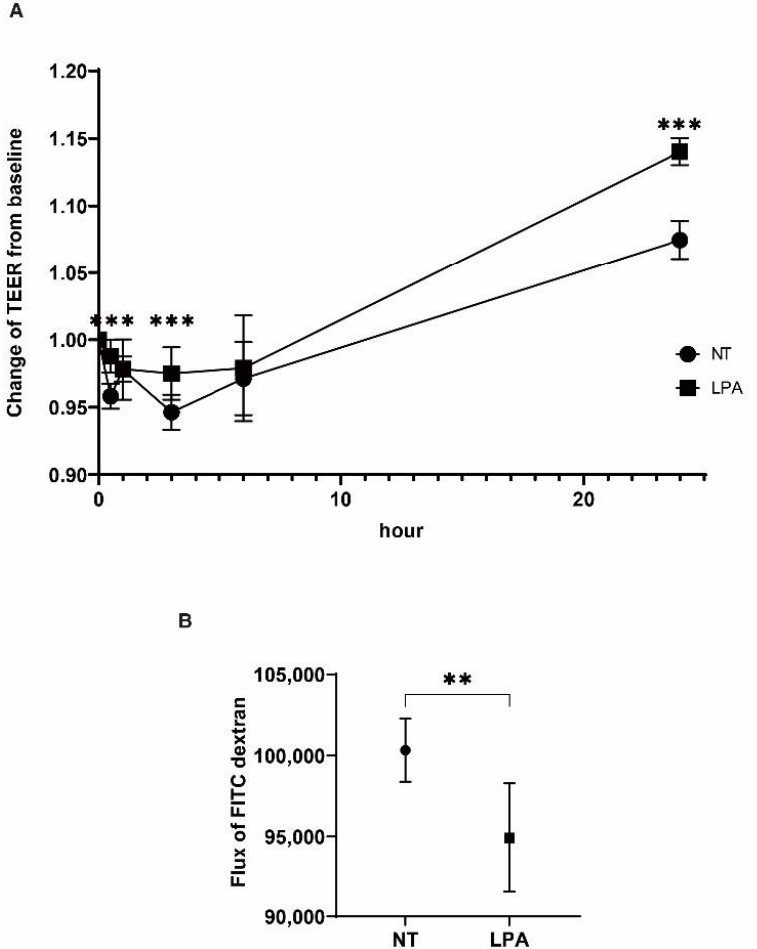
Figure 2. Effects of LPA on transendothelial electrical resistance (TEER) and FITC-dextran permea- bility of 2D cultures of HTM cell monolayers. Among the conditions in which the 2D cultured HTM monolayers were either untreated (NT) or treated with 200nM LPA, TEER (Ωcm 2 ) values were meas- ured at different time points (0, 0.5, 1, 3, 6 and 24 h) and plotted (panel A ). Alternatively, 2D cultured HTM monolayers were either untreated (NT) or treated with 200 nM LPA for 24 h, and was FITC- dextran permeability was measured and the data plotted in panel B . All experiments were per- formed in triplicate using fresh preparations ( n = 4). Data are presented as the arithmetic mean ± standard error of the mean (SEM). ** p < 0.01, *** p < 0 .005 (ANOVA followed by Tukey’s multiple comparison test).